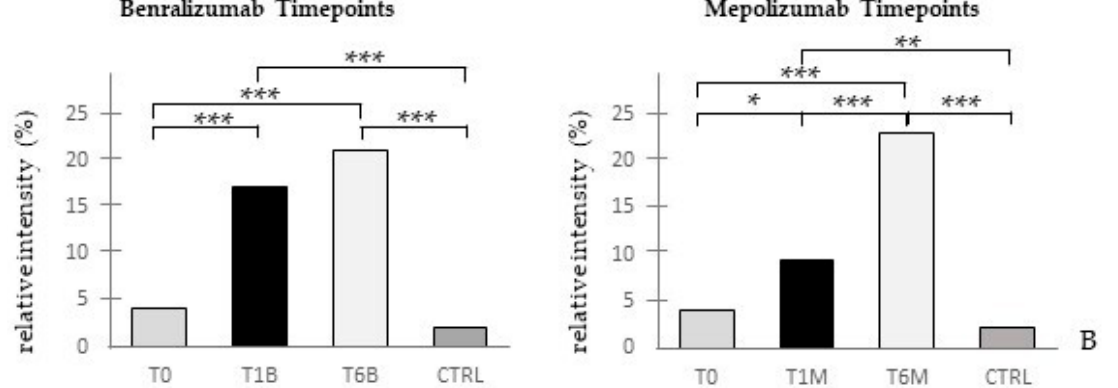
Figure 8. ( A ) The 2D-Western blot analysis with anti-plasminogen antibody on serum sample SEA patients at T0, T1M, T6M, T1B, and T6B, CTRL. ( B ) Histograms report the relative intensities of the spots and the HSD Tukey p -values. * Indicates significant level p < 0.05. ** Indicates significant level p < 0.005. *** Indicates significant level p < 0.0001.